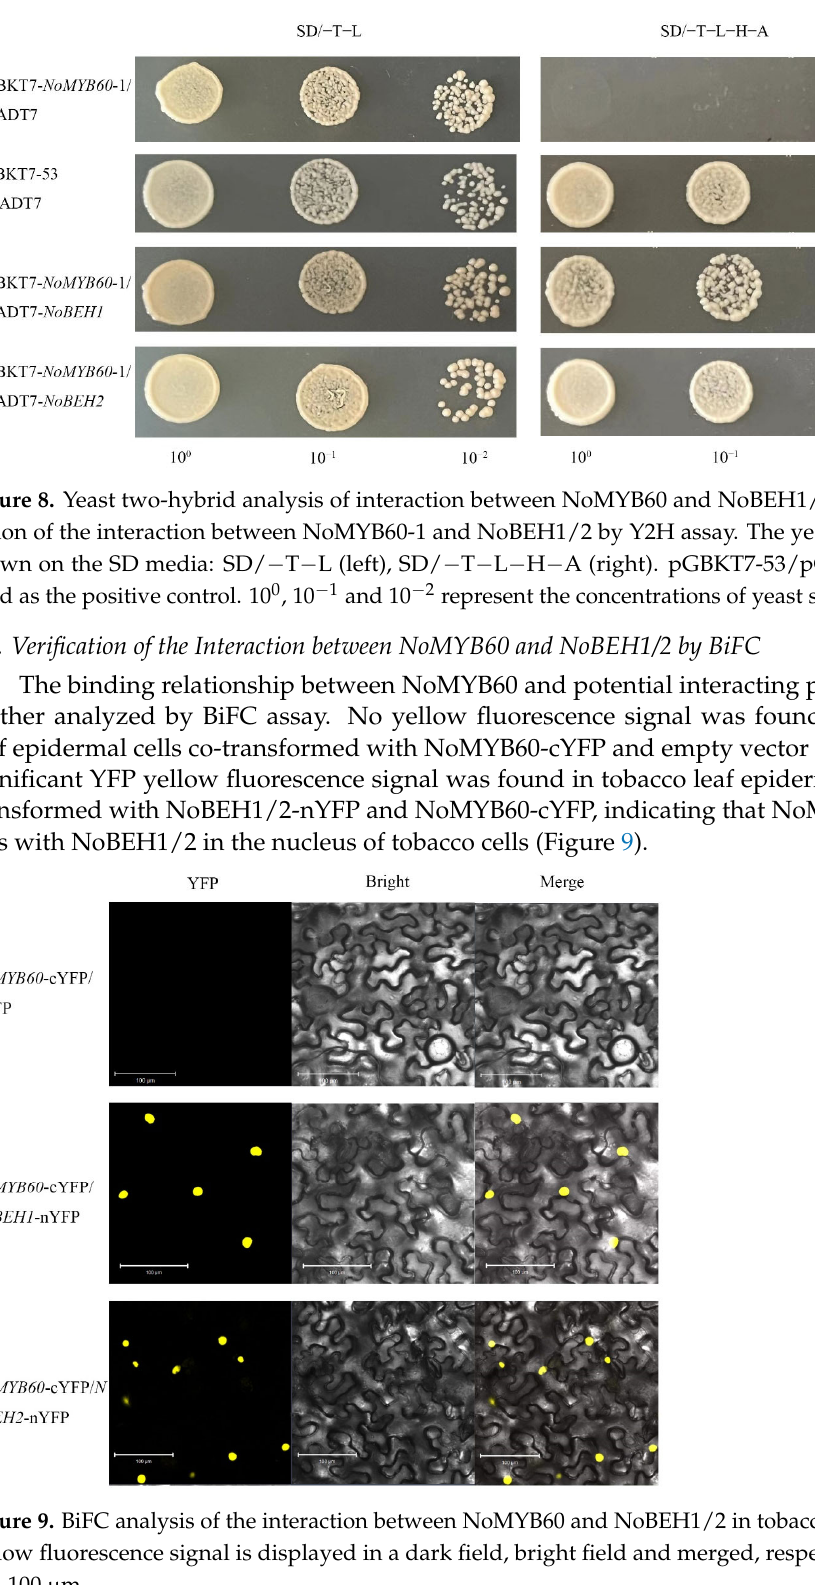
Figure 7. Transcriptional activation activity analysis of NoMYB60 . Transcription activity assay of NoMYB60 in yeast. NoMYB60 and NoMYB60 ‐ 1 represent the full ‐ length protein, as well as the re ‐ gions encoding 1–277 amino acids of NoMYB60, respectively, which were inserted into the pGBKT7 vector. In the Y2H assay, we discovered that co ‐ transformation containing the PGADT7 ‐ No ‐